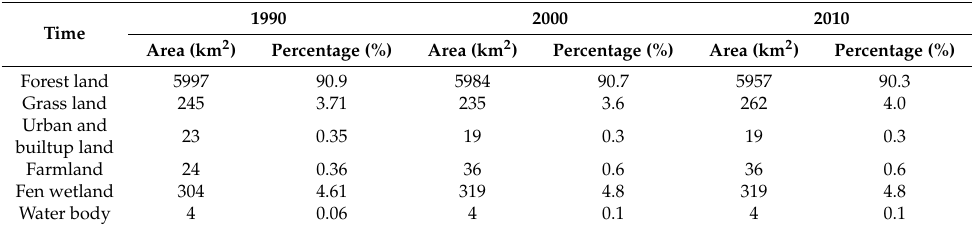
Table 1. Land use in the Tahe watershed in 1990, 2000 and 2010.